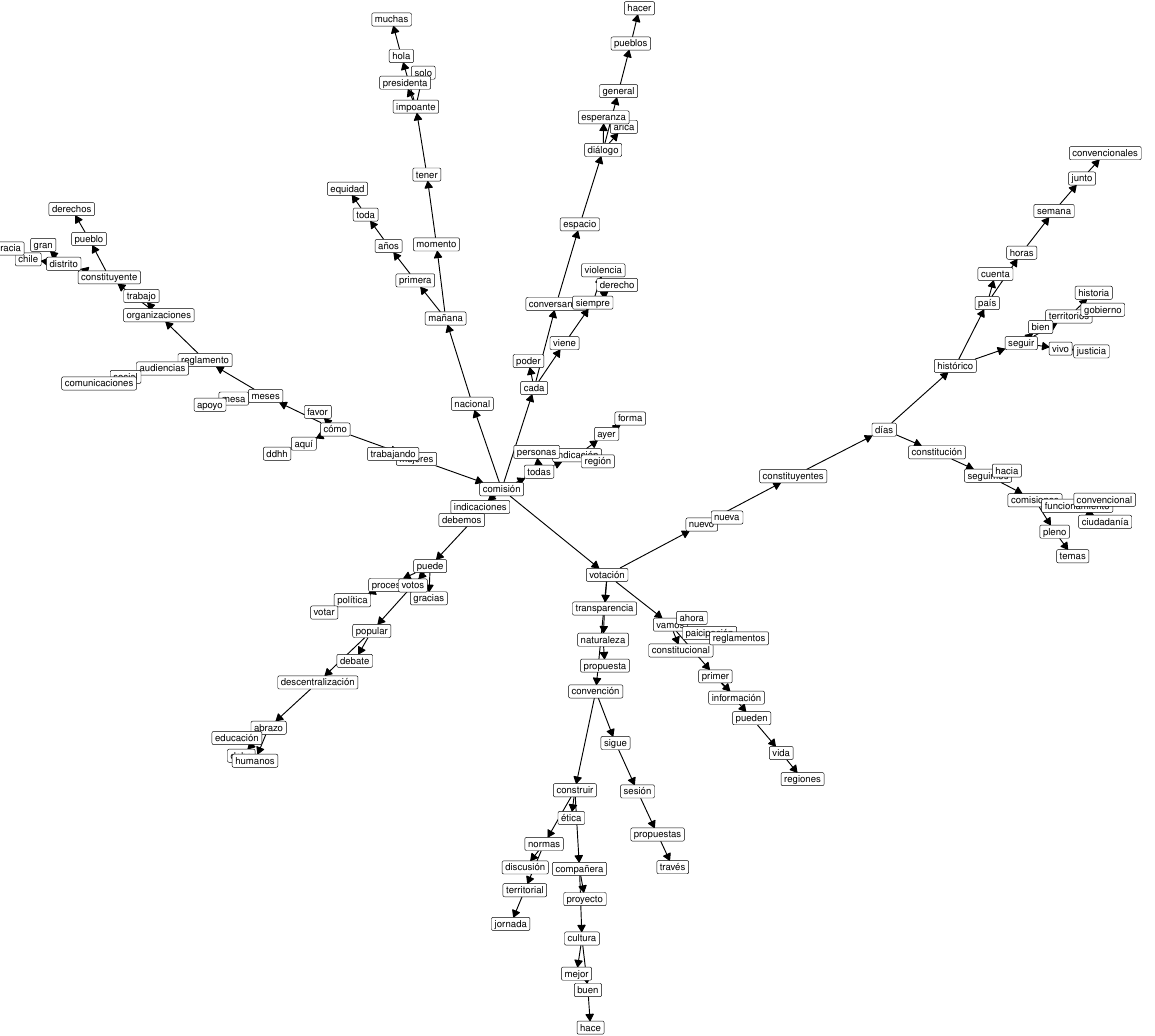
Figure 8. Examples of solutions achieved using ( µ , λ ) -TAN for the cluster 2 dataset. According to this, in Figure 8, we observe some interesting directed edges: (a) conver- sando (conversation) → espacio (space) → diálogo (dialogue) → esperanza (hope), as well as the bifurcation diálogo (dialogue) → general → pueblos (people); (b) votación (ballots) → transparencia (transparency) → convención (convention); (c) trabajo (work) → consti- tuyente (member of the convention) → pueblo (people) → derechos (rights); and (d) Chile → democracy (democracia) → públicas (policy). In this case, the network construction reveals a rather liberal conception of democracy in which, through spaces of conversation and dialogue, the hopes of the people can be addressed [71]. The transparency of demo- cratic procedures is also mentioned in the network, as well as the (hard) work carried out by the Constitutional Convention for the rights of Chilean “pueblo” (people). Unlike